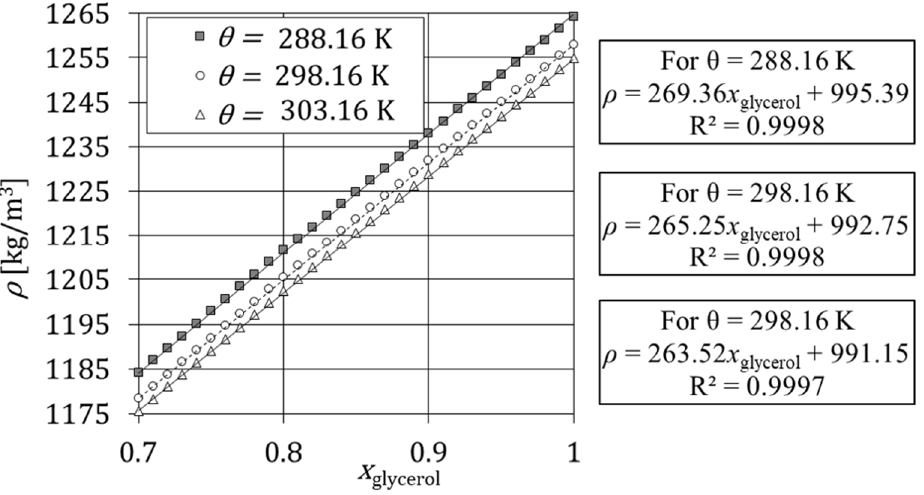
Figure 2. Variation of density of glycerol solutions versus the mass fraction of analytical and industrial glycerol, x glycerol , at θ = 288.16 K.